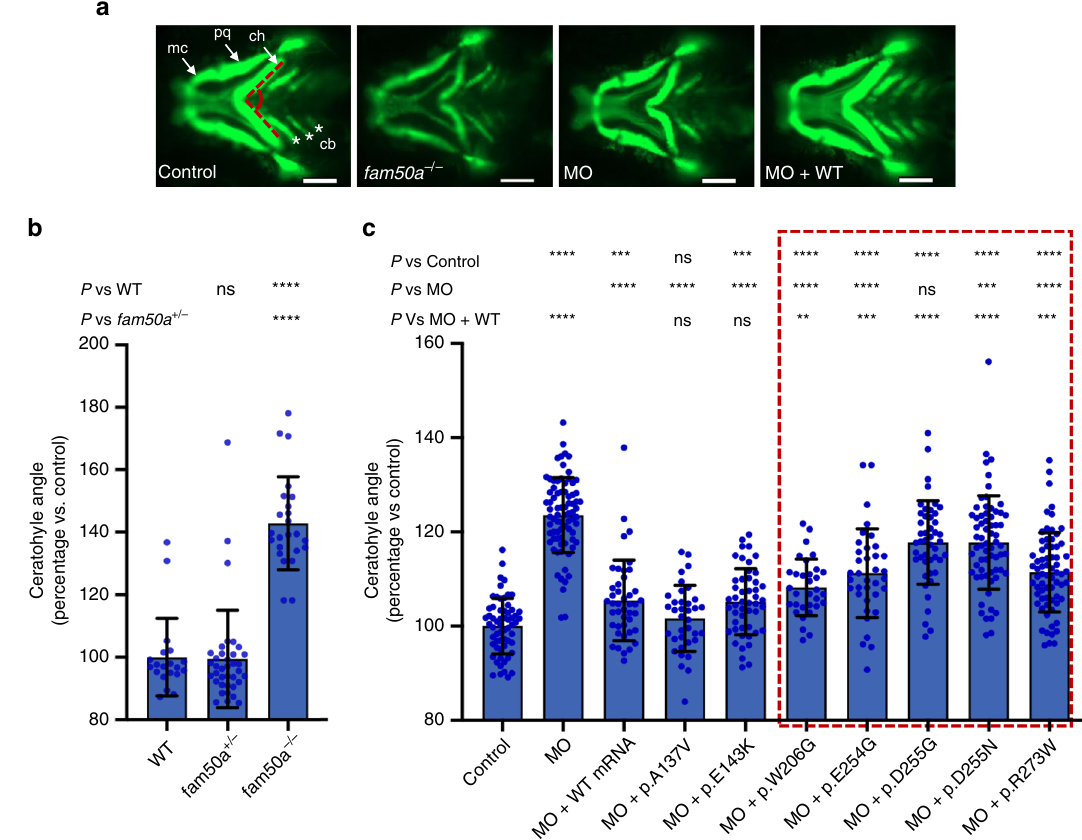
Fig. 3 In vivo assays indicate that FAM50A missense variants confer a partial loss of function. a Representative ventral views of craniofacial structures imaged live using the VAST BioImager in -1.4col1a1:egfp zebra fi sh larvae at 3 days post-fertilization (dpf). mc, Meckel ’ s cartilage; pq, palatoquadrate; ch, ceratohyal arch; cb, ceratobranchial arches. Red dashed lines on control image indicate the ch angle measured to quantify altered cartilage patterning in wild-type (WT) control, KO (homozygous mutants) or morphants. 5 ng morpholino (MO) and/or 150 pg of human FAM50A mRNA were injected for all assays. Scale bars, 100 μ m. b Quanti fi cation of ch angle in fam50a KO, fam50a + / − (heterozygous mutant) and WT. Heterozygous and WT animals are indistinguishable; ch angle was signi fi cantly increased in fam50a KO. **** indicates p < 0.0001. ns, not signi fi cant (unpaired Student ’ s t -test, two-sided). See Supplementary Table 4 for exact p -values. Left to right: n = 20, 37, and 24 larvae per condition, respectively . c In vivo complementation studies indicate that FAM50A variants in XLID males are pathogenic. Quanti fi cation of ch angle as indicated by measurements of ventral images ( a ), and statistical comparison of variant mRNA vs WT mRNA rescue of MO effect indicates that patient-associated variants are hypomorphic (partial loss of function; red dashed box). p.Ala137Val (A136V; rs149558328) and p.Glu143Lys (E143K; rs782017549) are present in hemizygous males in gnomAD and were scored